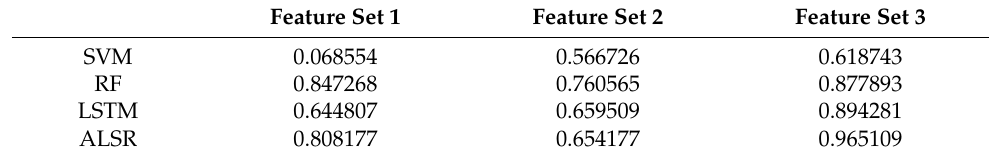
Table 10. F1-scores for different feature sets